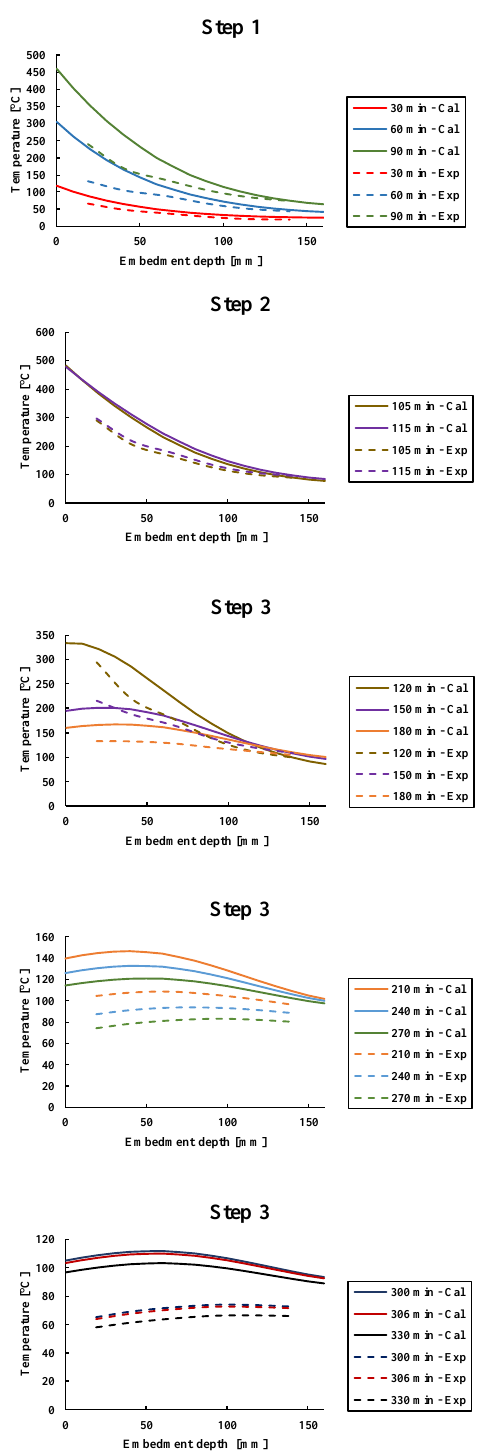
Figure 8. Comparison between experimentally and numerically measured temperature profiles along the rebar interface. Explanations for each step of Figure 8 were described in Section 4.1. Step 3 in Figure 8 was represented in three figures, where the temperature — embedment depth relationship was presented from 120 min to 330 min.